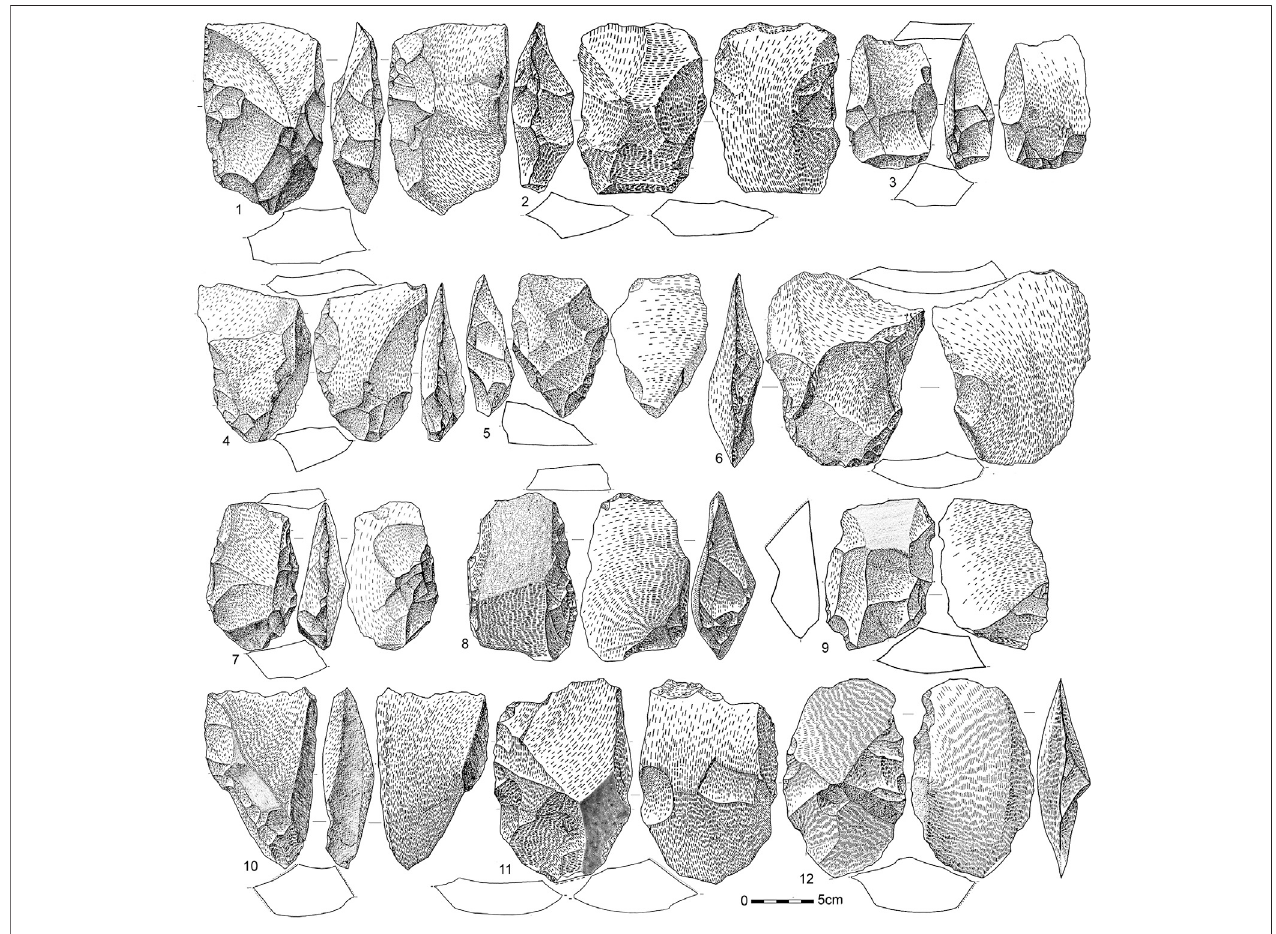
FIGURE 12 | Type II cleaver on fl ake (1-7), and variants with a cortical edge (8-9) and partially shaped on the core (10-12). All on quartzite.